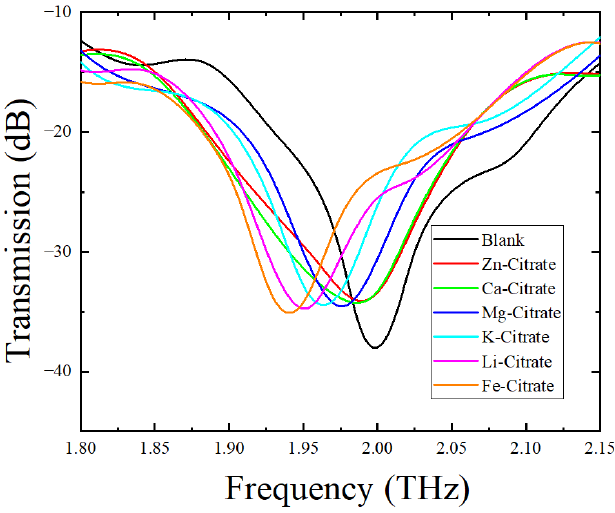
Figure 6. Transmission spectral curves of the blank sensor and the sensor covered with six differ-